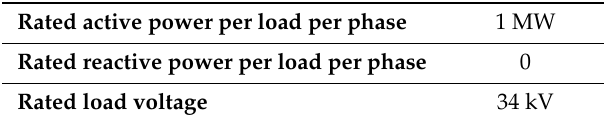
Table A5. Wind turbine energization loss data implemented in